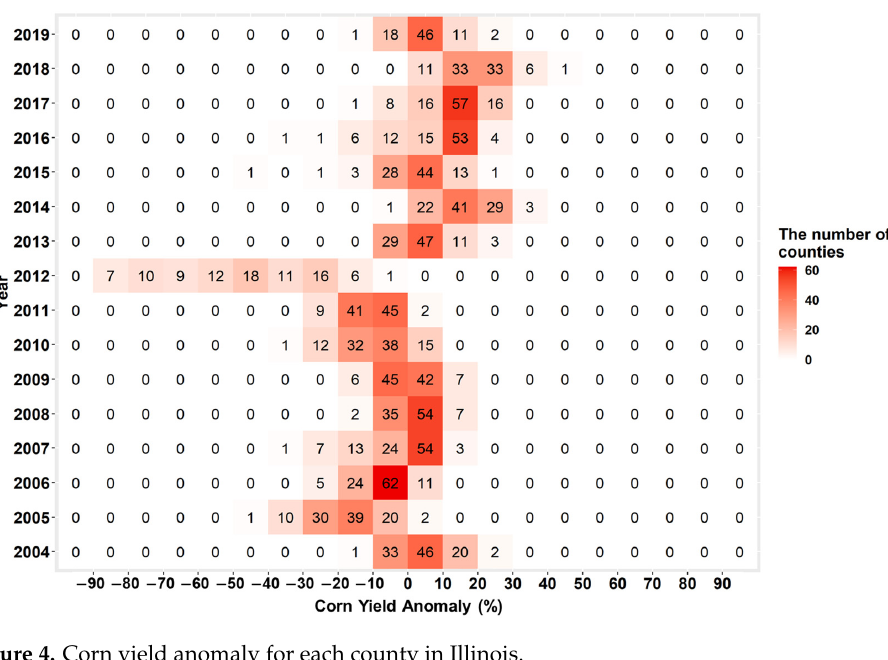
Figure 4. Corn yield anomaly for each county in Illinois. Table 4. Severely and moderately damaged counties selected from Illinois, USA.